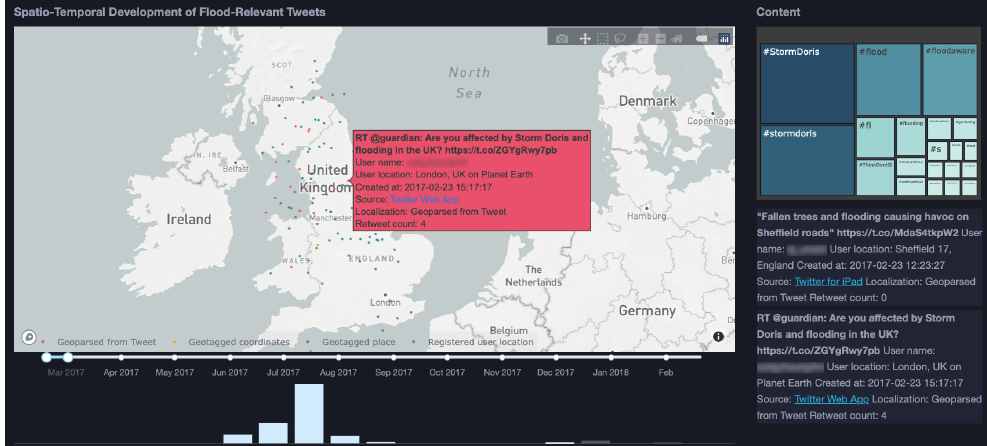
Figure 11. Inspection of tweets related to Storm Doris in the scatter map, treemap, and scrollable